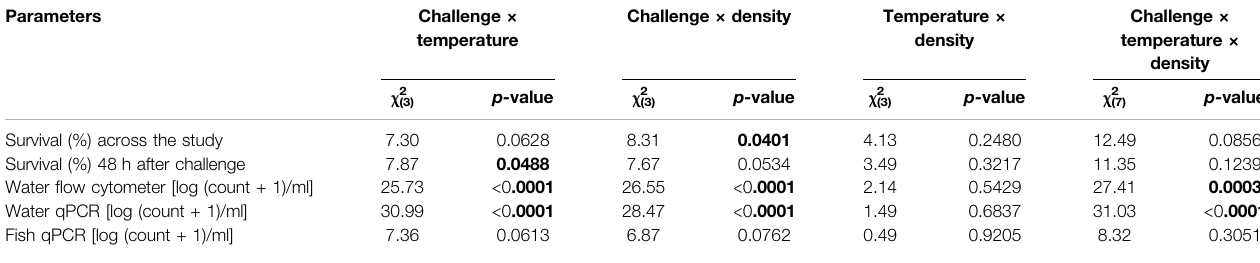
TABLE 2 | Statistical analysis results (test statistics, degrees of freedom, and p -value) of two-way interactions (groups = 4) and three-way interactions (groups = 8) between the three main effect variables (challenge, temperature, and density) for survival, fi sh qPCR, water qPCR, and fl ow cytometer bacterial count of F. covae in water. Signi fi cant results at p < 0.05 if bold